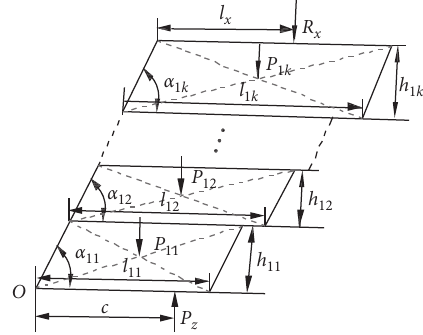
Figure 6: Roof combined cantilever beam structural